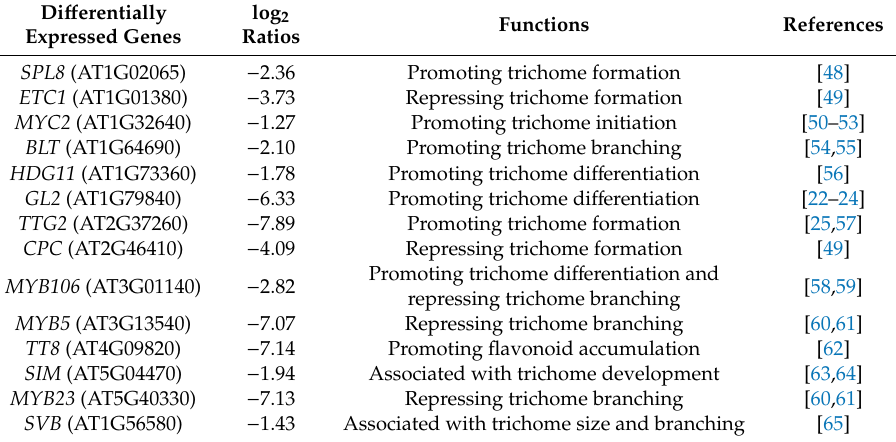
Table 1. Di ff erentially expressed genes (DEGs) contributing to trichome formation in the young shoots and expanding true leaves of ttg1-13 plants at 20 days after germination. DEGs with | log 2 ratios | ≥ 1.00, and only GO Slim IDs with FDR ≤ 0.05, are listed here.